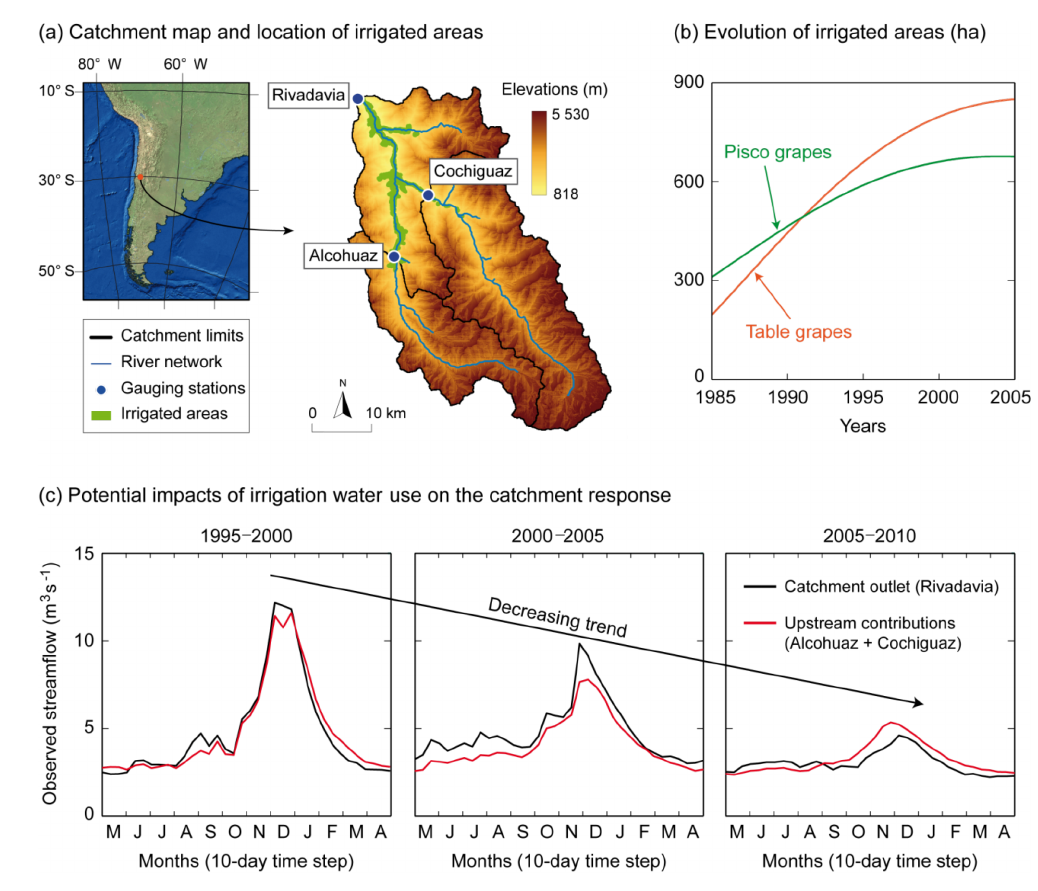
Figure 1. The Claro River catchment, Chile (30 ◦ S): (a) topography and current location of irrigated areas, (b) evolution of irrigated areas since 1985 (interpolated from local cadastral surveys) for both types of grapes, and (c) potential effects of increased irrigation water use on mean annual hydrographs since the mid-1990s. These effects were estimated from the difference between streamflow measured at the outlet in Rivadavia (in black) and that measured at Cochiguaz and Alcohuaz (in red), which remains largely